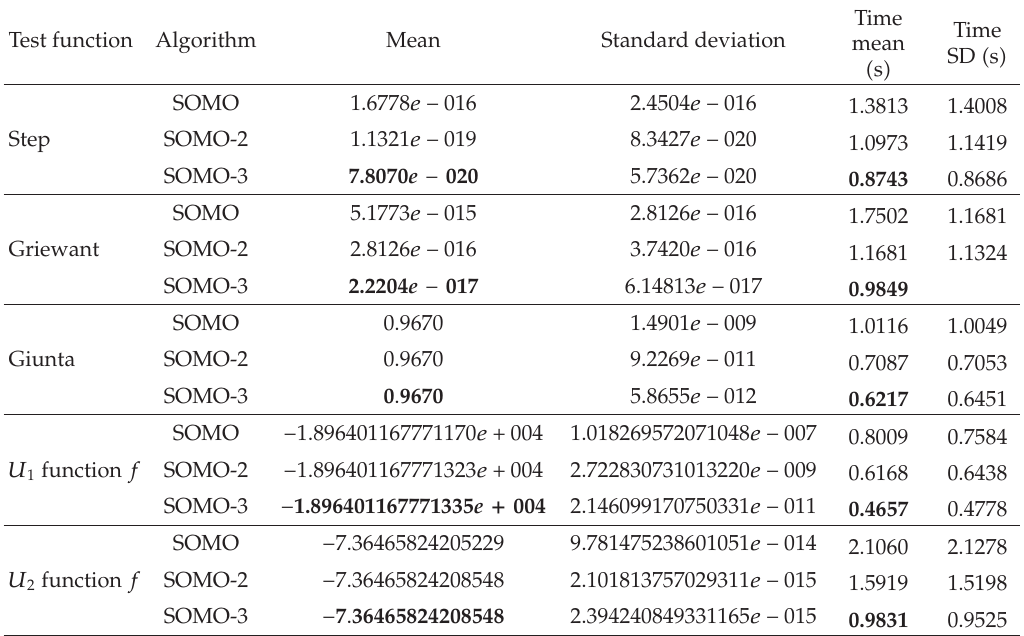
Table 2: Comparison of SOMO, SOMO-2, and SOMO-3 for finding one minimum. Test function